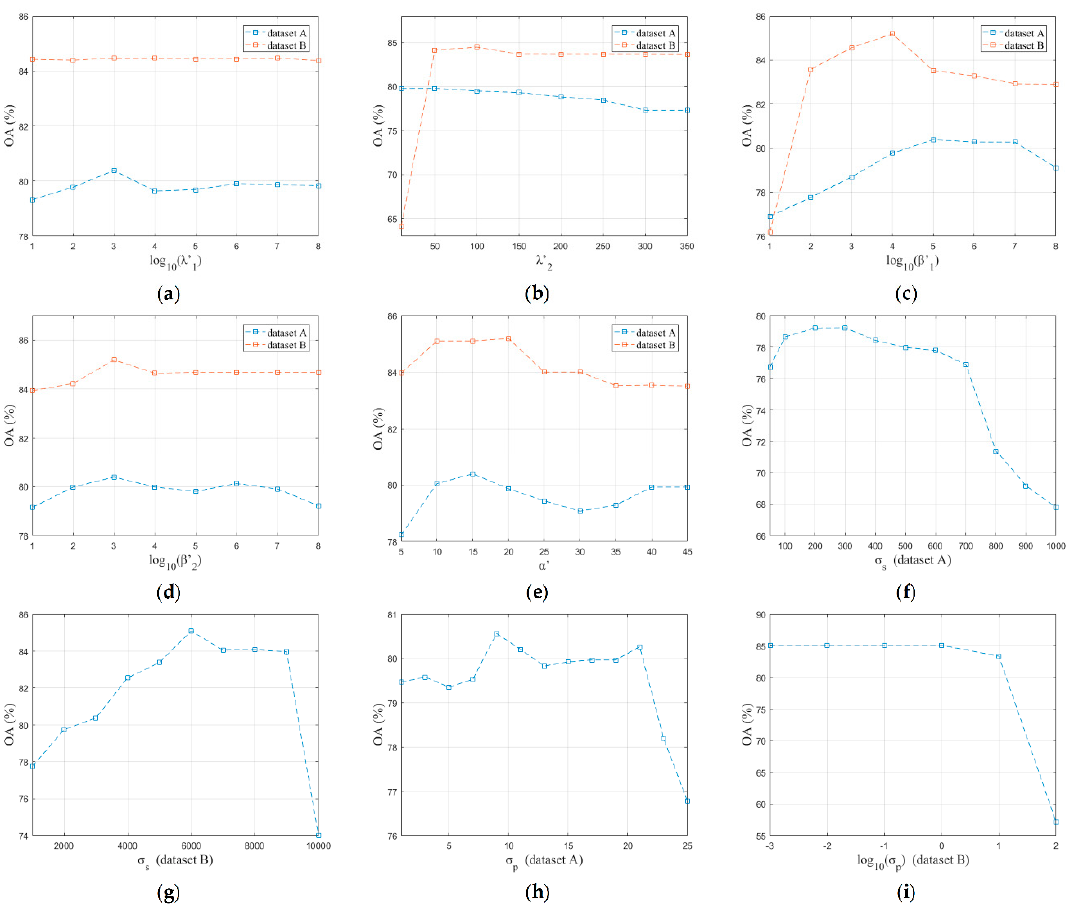
Figure 6. Analysis of parameters. Change in the overall accuracy and in-sample accuracy with various values of: ( a ) λ 1 (cid:48) of dataset A and dataset B; ( b ) λ 2 (cid:48) of dataset A and dataset B; ( c ) β 1 (cid:48) of dataset A and dataset B; ( d ) β 2 (cid:48) of dataset A and dataset B; ( e ) α (cid:48) of dataset A and dataset B; ( f ) σ s of dataset A; ( g ) σ s of dataset B; ( h ) σ p of dataset A; ( i ) σ p of dataset B.